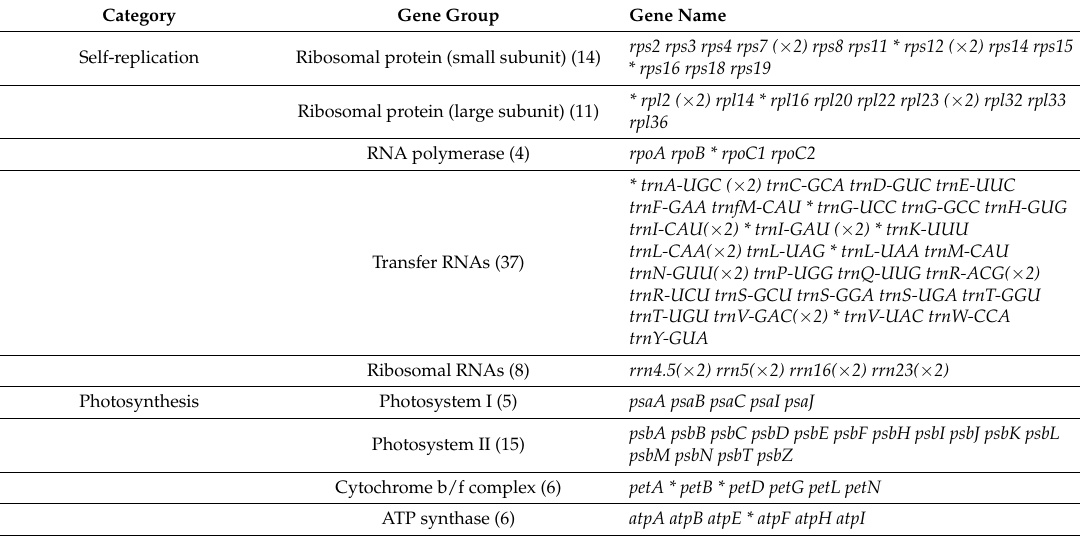
Figure 1. Gene maps of chloroplast genomes of Cucurbitaceae. Genes on the inside of the large circle are transcribed clockwise and those on the outside are transcribed counterclockwise. The genes are color ‐ coded based on their functions. Dashed area represents the GC composition of the chloroplast genome. Table 2. List of genes in the chloroplast genome of three newlysequenced species.